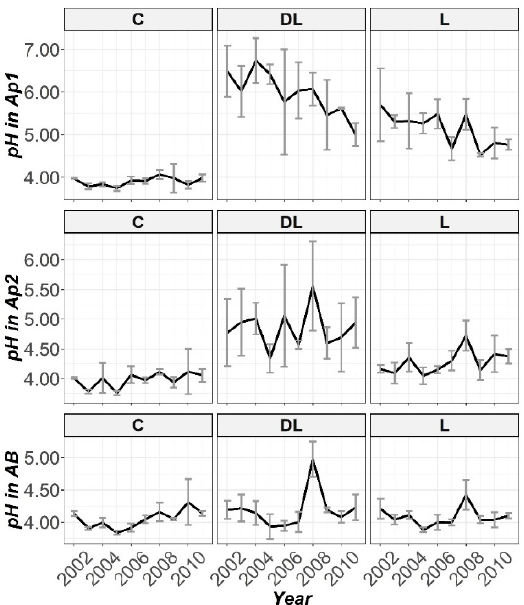
Figure 1. Temporal evolution of pH in the three horizons (Ap1, Ap2 and AB) studied throughout the ten years of soil monitoring (2002–2011).